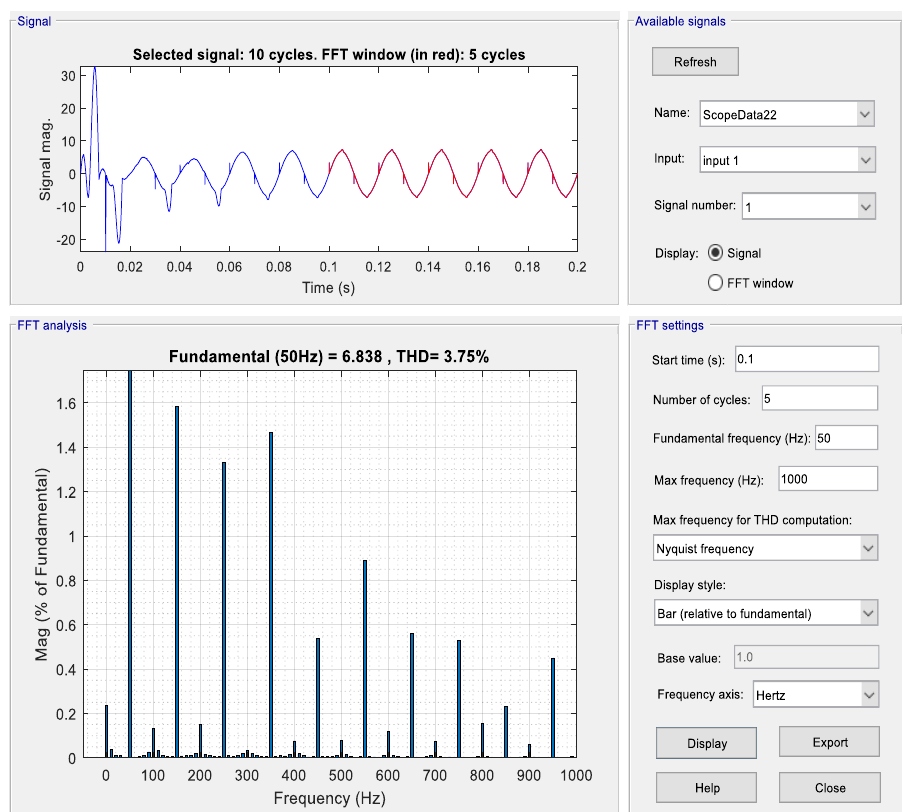
Figure 38. %THD of Source Current with ANN Based Filter In HIL Topology.